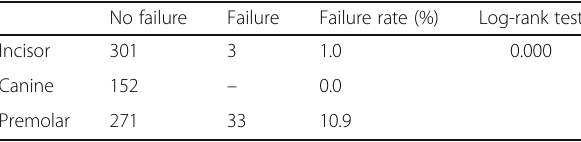
Table 3 Bond failure rates for type of tooth (incisor, canine, and premolar)*